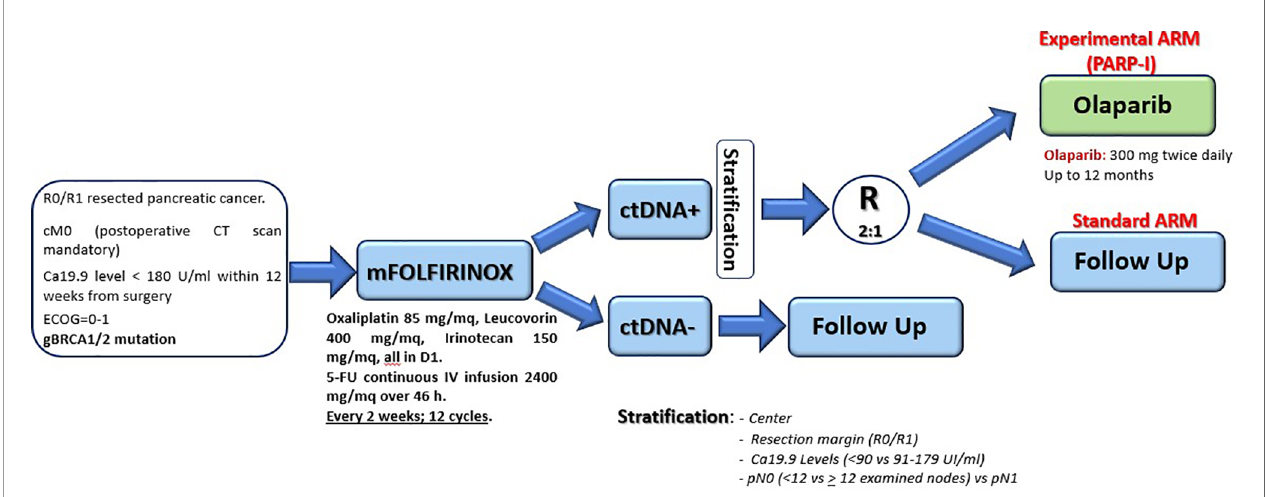
FIGURE 2 | Hypothetic adjuvant study design dedicated to germline BRCA1/2 mutated PDAC